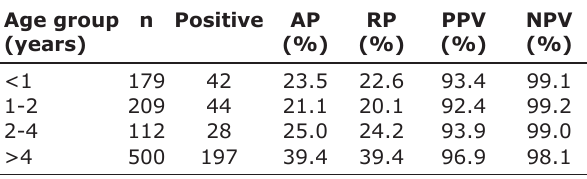
Table-4: Analysis of infectious diseases as a risk factor associated with BLV